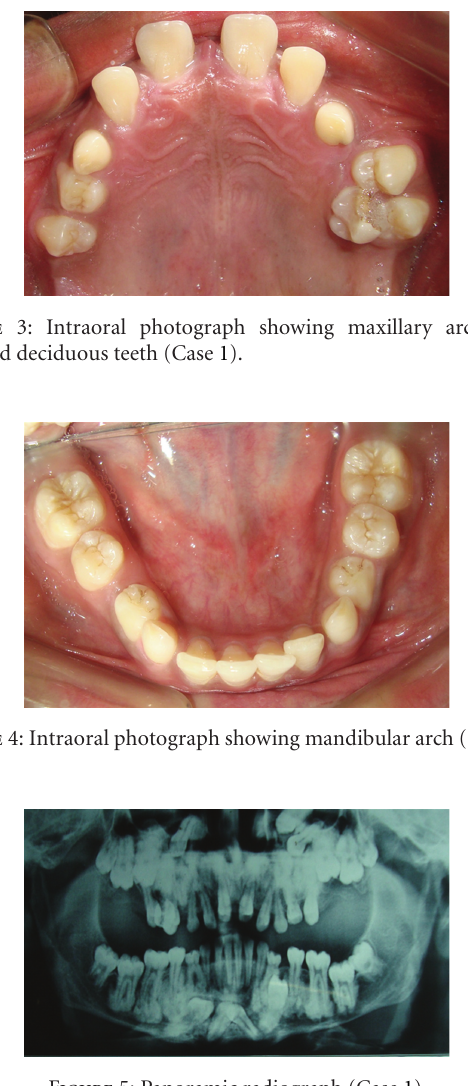
Figure 5: Panoramic radiograph (Case 1).